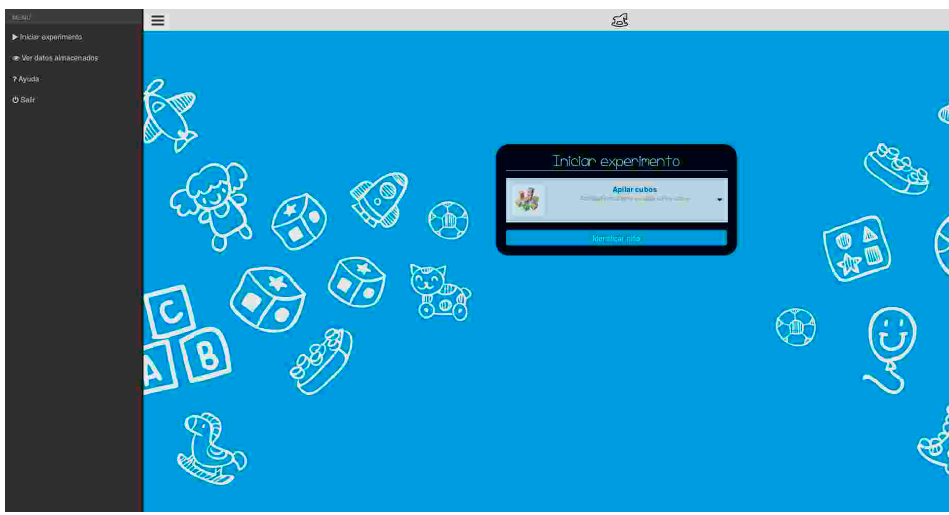
Figure 20. Screenshot of the collector web interface.